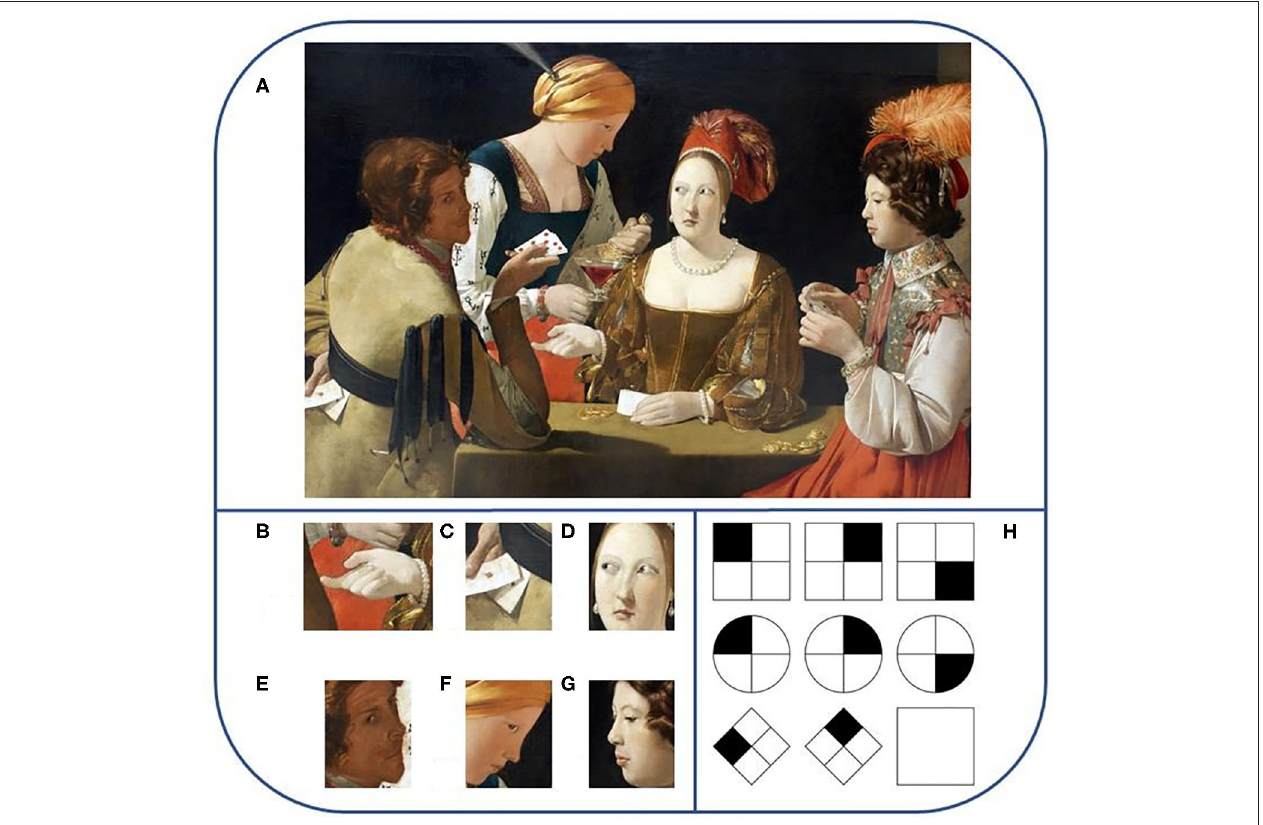
FIGURE 1 | The difference between the complexities of social interactions and IQ tests. (A) The variables: we see a scenario of four people, their individual roles in the scenario, their relative positions in three dimensions to be estimated from a two-dimensional projection, occlusions of diverse objects and body parts for each person, the role of gaze directions (looking away, looking into the cards, looking at somebody), attention (seemingly no card-related attention, attention to own cards, attention to a person), objects in the hands (nothing, card or cards, glass of wine, bottle of wine), role of the hand (context restricted role of the hands within the context of the card game (showing the cards, hiding cards, covered pointing), the role of different cards in the game (ace vs. other cards), role of people (players, maid), the general posture and motion of the people (sitting, walking), and the related potential observations (unobservable and observable objects for different partners), hypotheses about past observation (has seen something), uncertain observations on facial expressions that the context can modify [compare (A) and (B–G) and the presumed goals (winning, making others to believe something, draw somebody’s attention to something, asking somebody in case of uncertainty) as well as the irrelevant variables related to clothes, hair styles, jewelry, light intensities, amount of money on the table, including the varieties of forms, colors, shapes, and so on]. Reproduced from https://www.wikiart.org/en/georges-de-la-tour/the-cheat-with-the-ace-of-diamonds under Public Domain license (See also the cover page of Uta Frith’s book: Autism: Explaining the Enigma, Blackwell Publishing, 1989). (H) A sample IQ test. The variables: (i) shape of the object (square and circle) is irrelevant, (ii) position of the black subfigure (clockwise rotation) is relevant. The subject is supposed to find the variables, to select the relevant one(s) and find the rule(s)